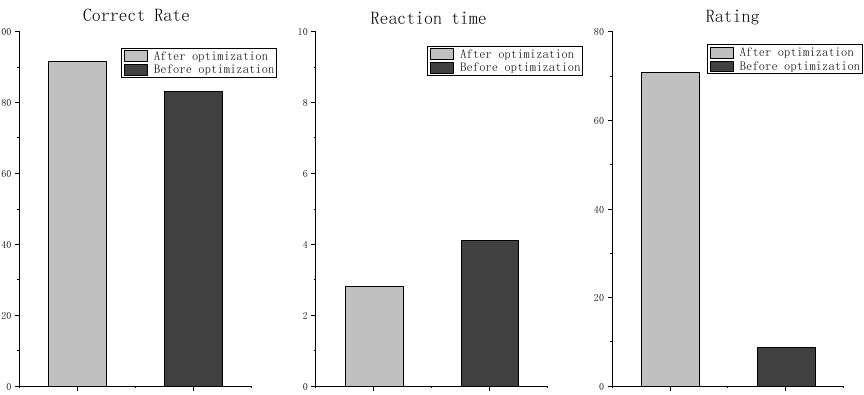
Figure 21. Combined comparison chart of the correct rate, response time, and score with and without auditory.